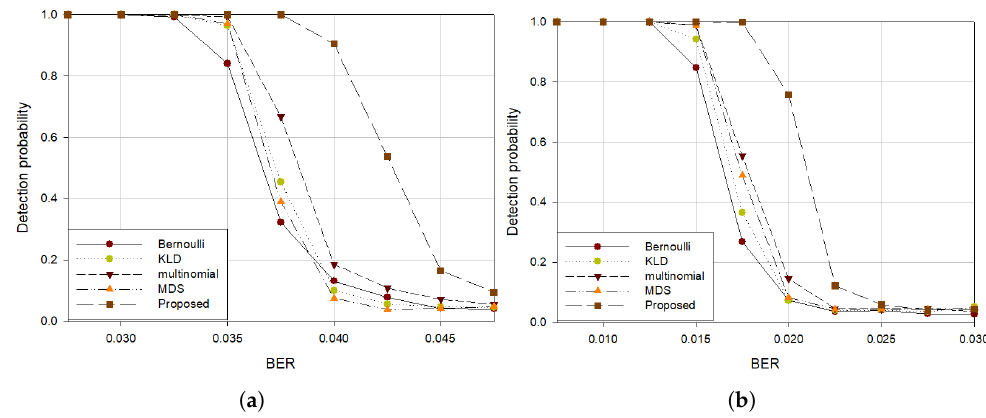
Figure 8. Detection probability ( a ) BCH(15, 7) code with S = 35, ( b ) BCH(15, 11) code with S =